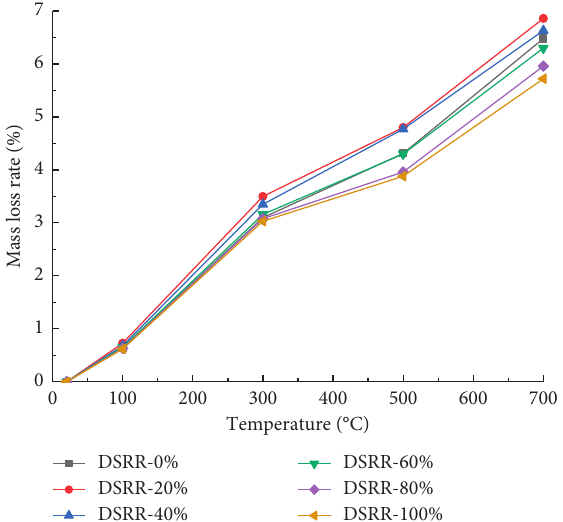
Figure 11: Relation between relative compressive strength and temperature.